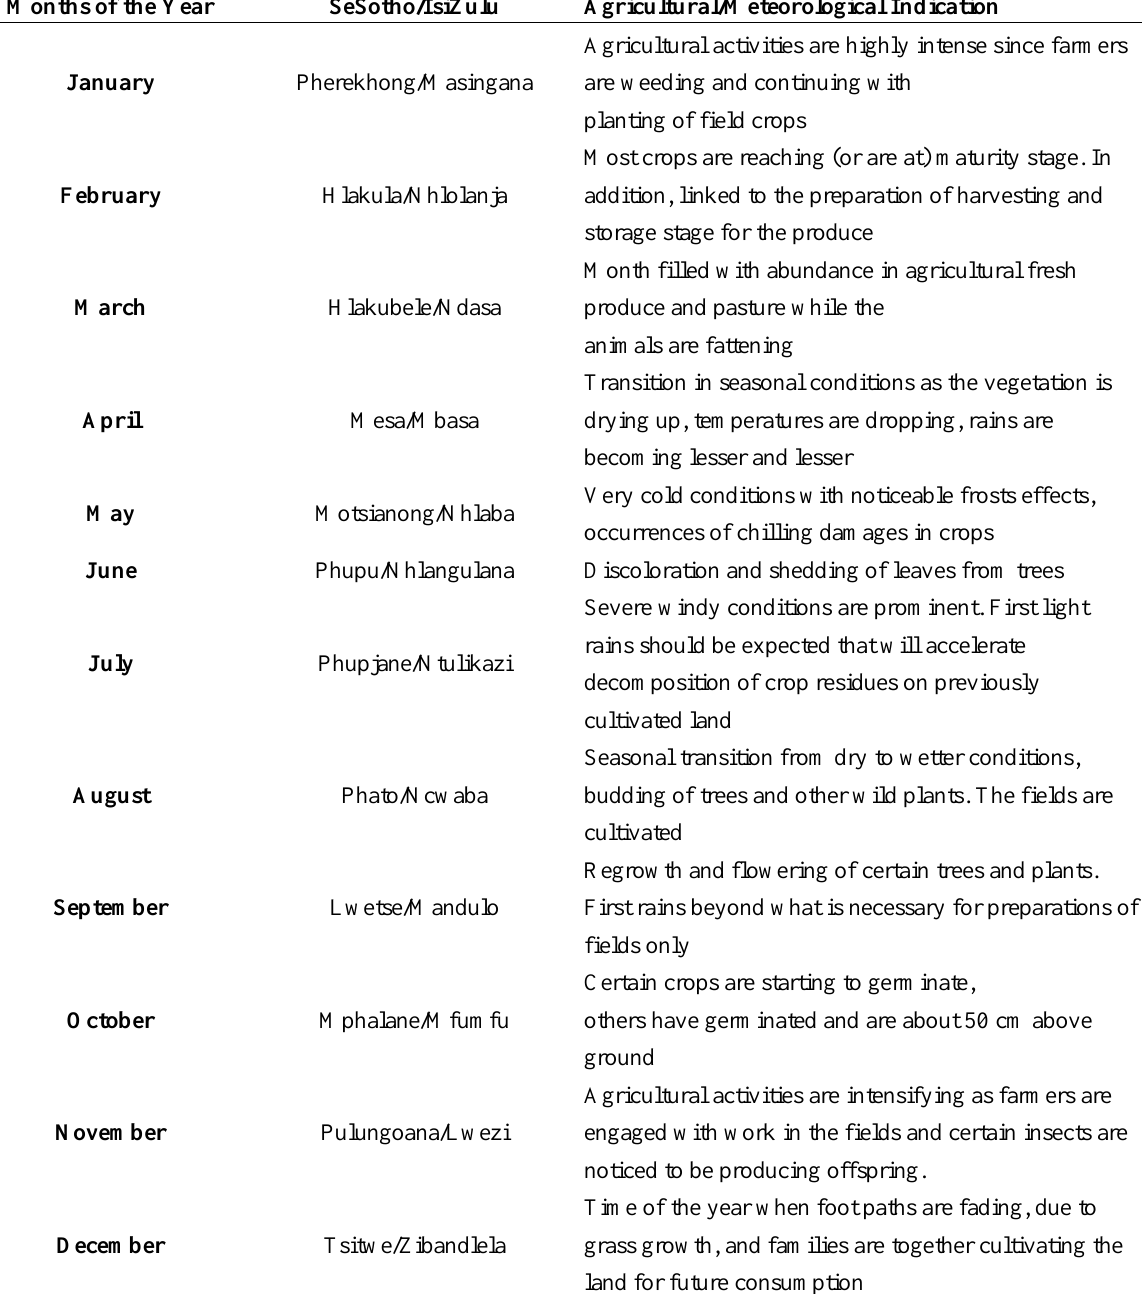
Table 1. Months of the year and their role as “forecasting elements” in agricultural timing as used by farmers in the study area before the influence of climate change. The SeSotho/IsiZulu names for these months hold elements of the English description given for each of these twelve months, as derived from interviews with farmers in 2008 and 2012